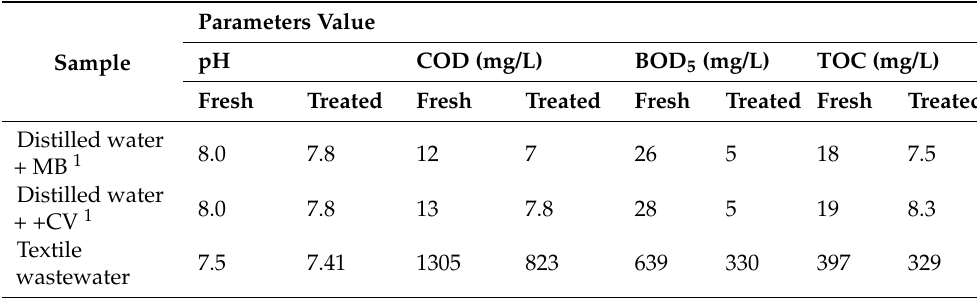
Table 3. Characteristics of the textile and synthetic wastewater (catalyst dose: 0.5 g/L, reaction time: 50 min, amount of H 2 O 2 : 40 mM/100 mL, and pH =